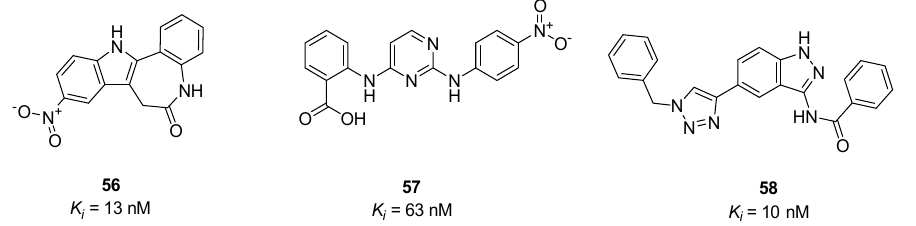
Figure 15. Examples of CDK5 ligands which were not successfully mapped to the 5-HT 6 R pharmacophore model.